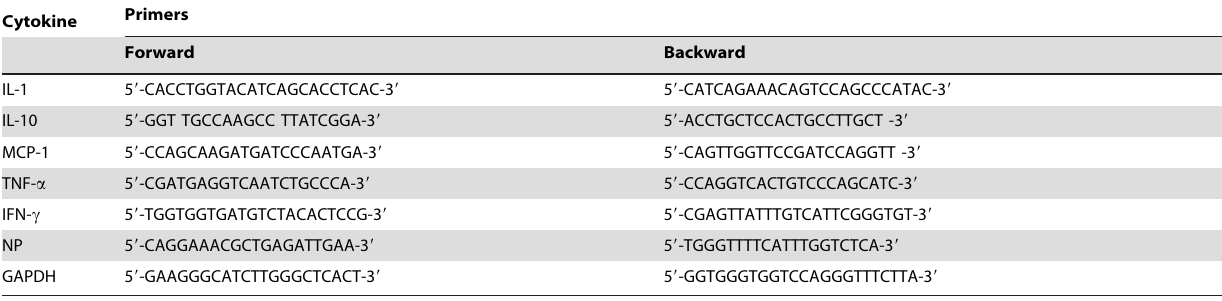
Table 1. Primers for real-time RCR.